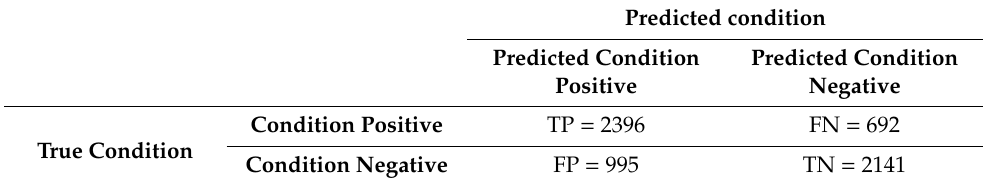
Table 11. Confusion matrix for stacking. (TP: true positive, TN: true negative, FN: false negative, FP: false positive).